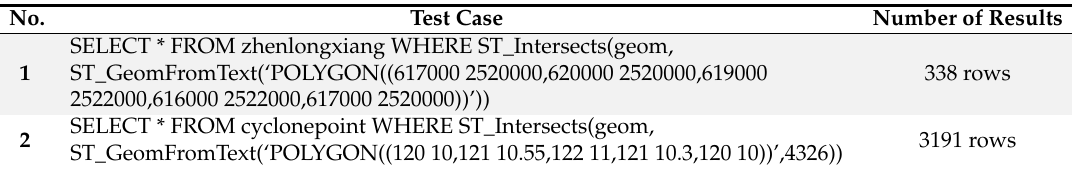
Table 12. Test cases of range queries.